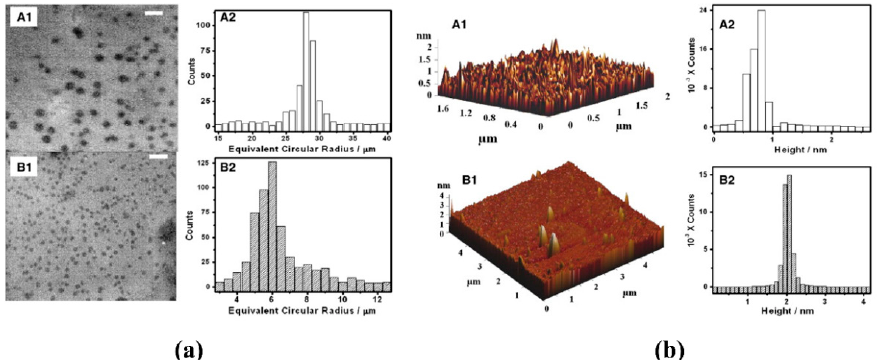
Figure 11. ( a ) Epifluorescence images of pure C 18 TA + DS − (A1) and C 18 TA + DS − –BSA (B1) films ([BSA] = 0.25 μ g mL − 1 ) with their corresponding histograms at π = 25 mN m − 1 at pH = 5.4 and T = 298 K.